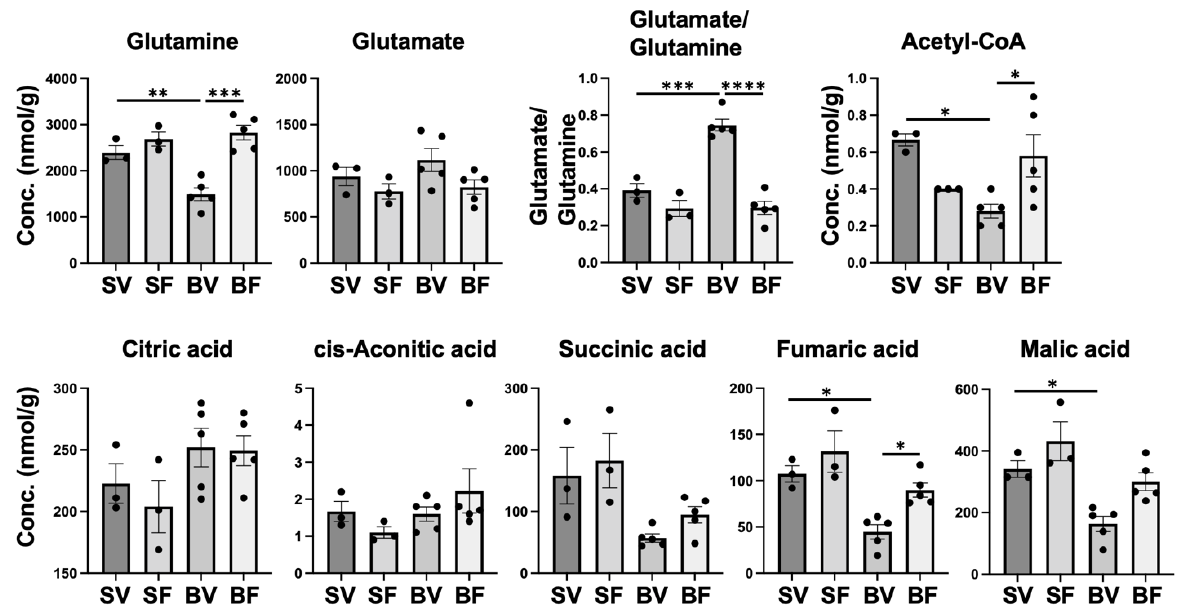
Figure 10. Effects of burn injury and FTI-277 on glutamine, glutamate, and TCA cycle intermediates. SV: Sham-Vehicle; SF: Sham-FTI; BV: Burn-Vehicle; BF: Burn-FTI, * p < 0.05, ** p < 0.01, *** p < 0.001, **** p < 0.0001.